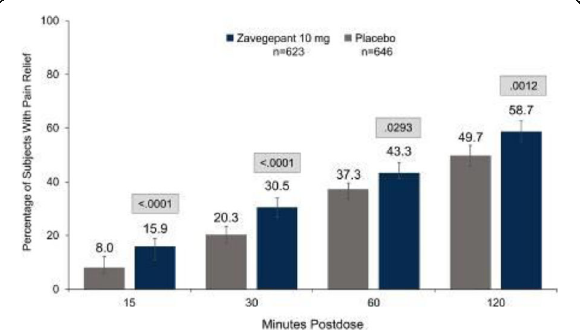
Fig. 2 (abstract P136a). Zavegepant Nasal Spray Versus Placebo in the Acute Treatment of Migraine: Pain Relief at 15, 30, 60, and 120 Minutes